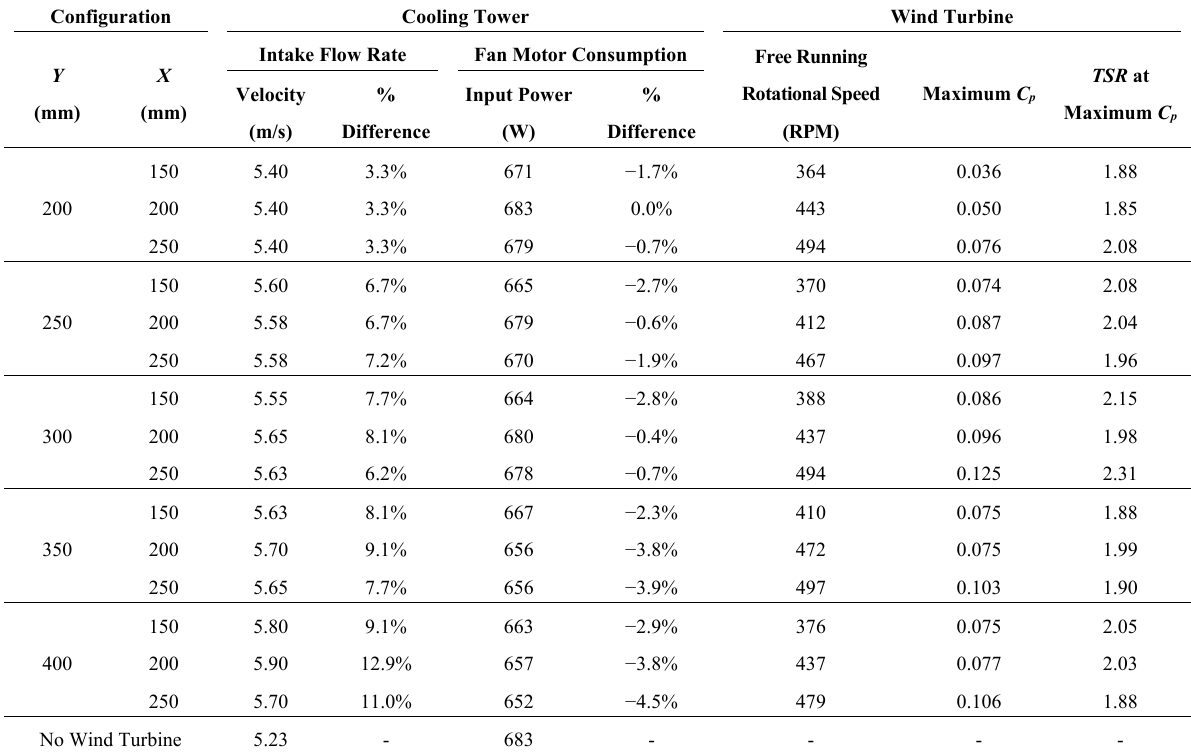
Table 1. Comparative performance of cooling tower and wind turbine compared to bare cooling tower.